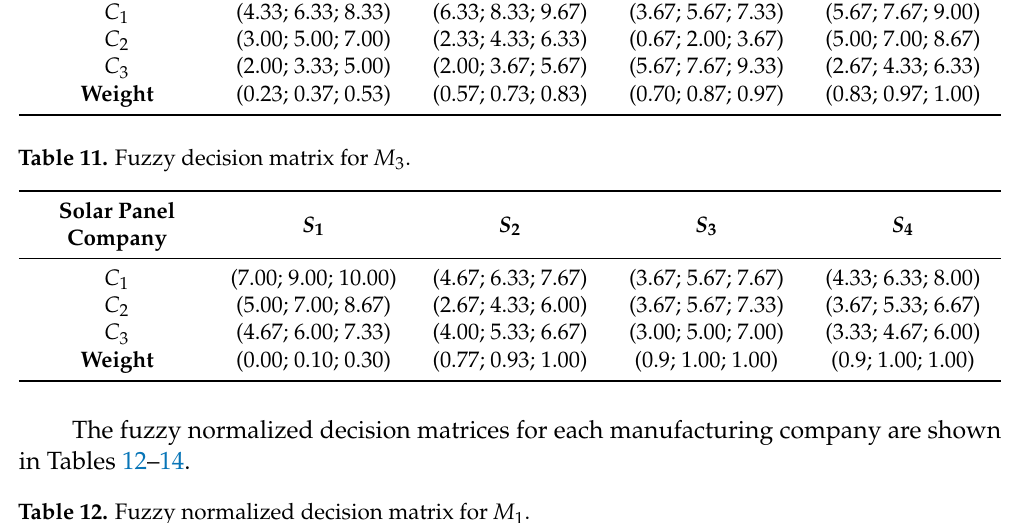
Table 12. Fuzzy normalized decision matrix for M 1 .